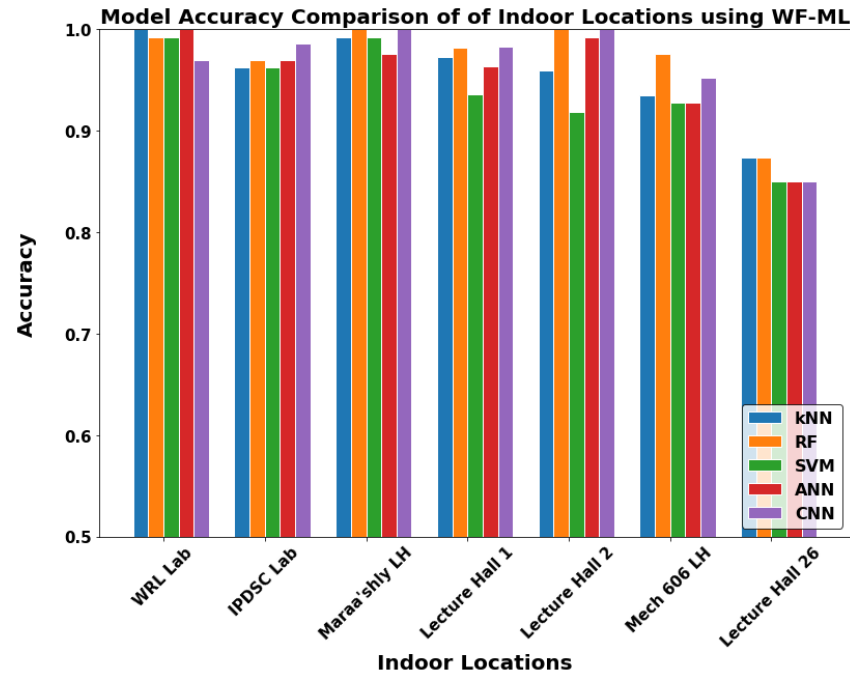
Figure 18. The models accuracy in all indoor geofences using WF-ML.